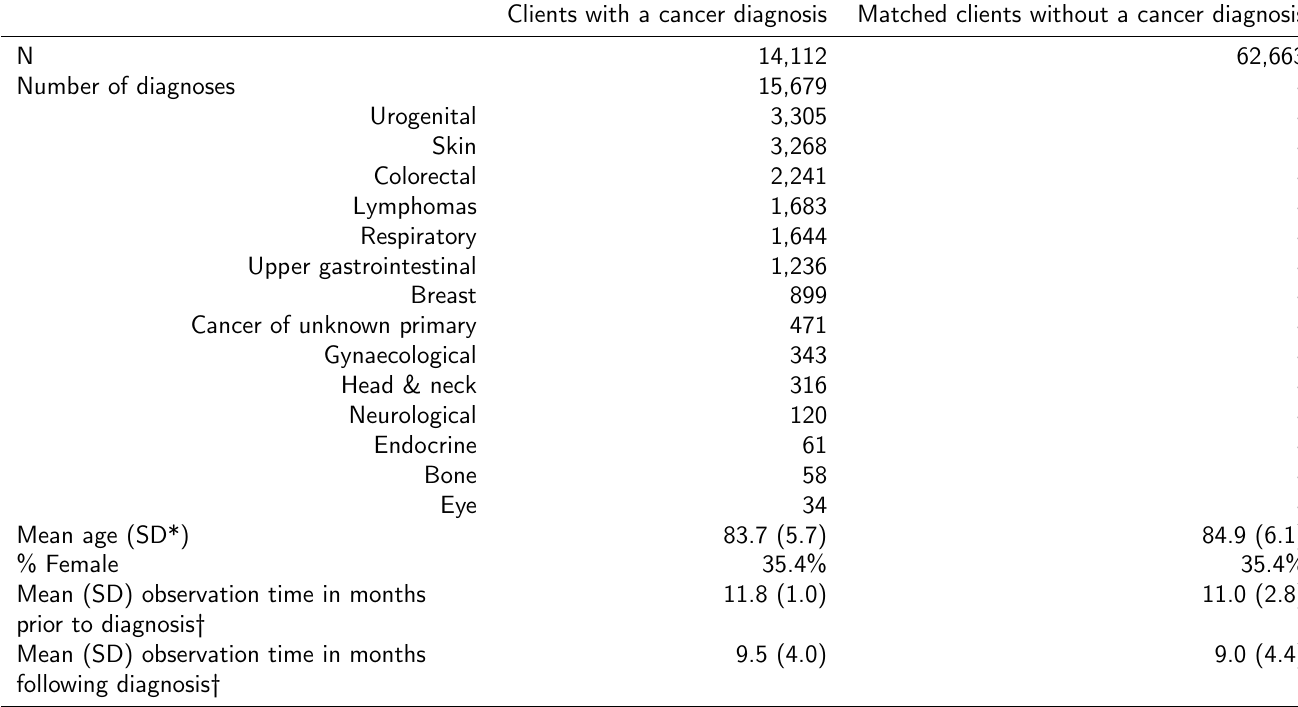
Table 1: Characteristics of DVA clients with cancer diagnosis and matched clients without a cancer diagnosis